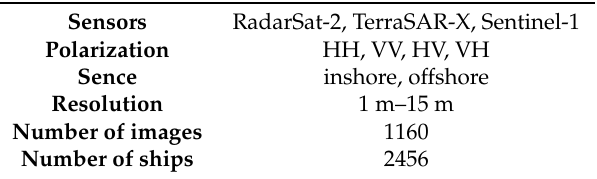
Table 1. Detailed description of